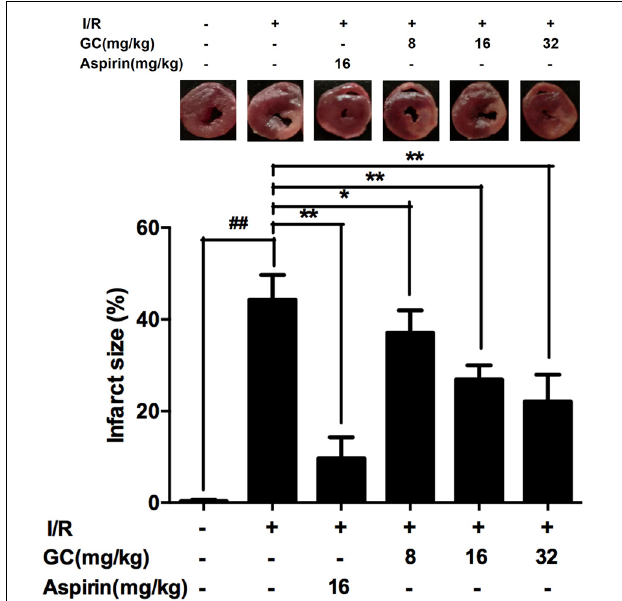
FIGURE 3 | Effect of GC on infarct size in MI/R injury rat model. Treatment with Aspirin and GC significantly reduced the infarct size in MI/R injury rat model. Data were expressed as mean ± SD ( n = 8). ## P < 0.01 vs. control group; ∗ P < 0.05, ∗∗ P < 0.01 vs. I/R group.